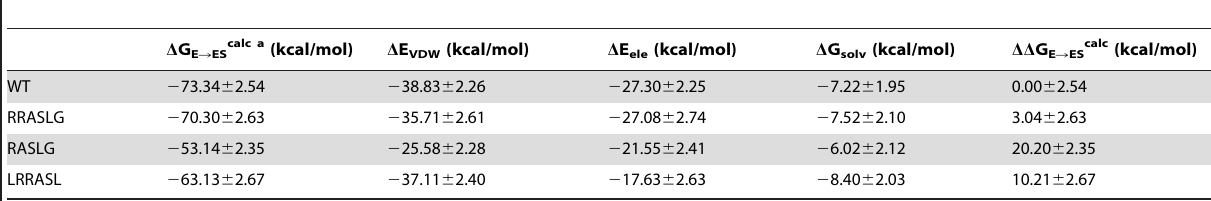
Table 6. Predicted relative MM-GBSA free energies (kcal/mol) and individual energy terms of the complexes between shorter chain peptides derived from Kemptide and